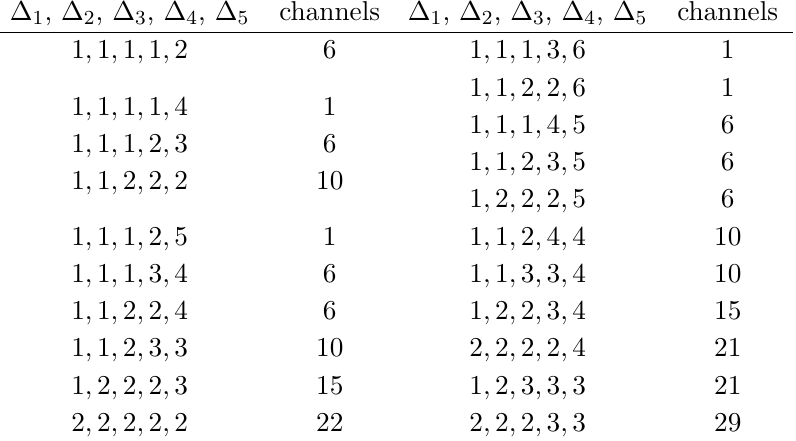
Table 1. Number of R -symmetry channels for different five-point functions, obtained by pinching n -point functions h O 1 . . . O 1 i from n = 6 to n = 12